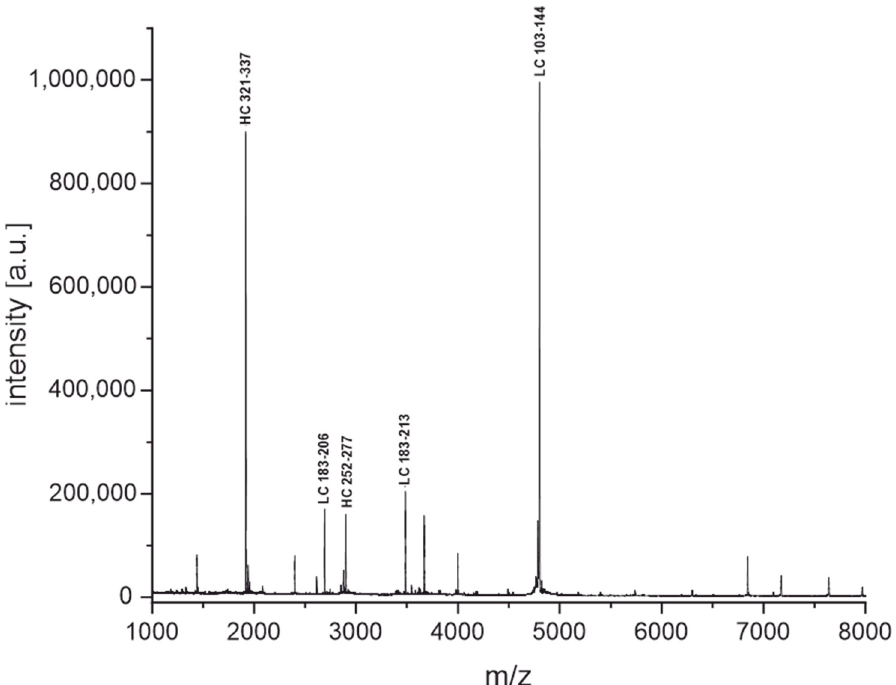
Figure 7. MALDI-TOF fingerprint spectrum of NIST-mAb 8671 after 15 min of incubation with TCEP at 99 °C, followed by 15 min of incubation with trypsin at 55 °C. The five most intense peptide peaks are assigned to the sequence of the NIST antibody in the spectrum (HC heavy chain, LC light chain). Sequence assignment was possible for most peaks (see SI, Figure S5). The sequence coverage was around 65%.